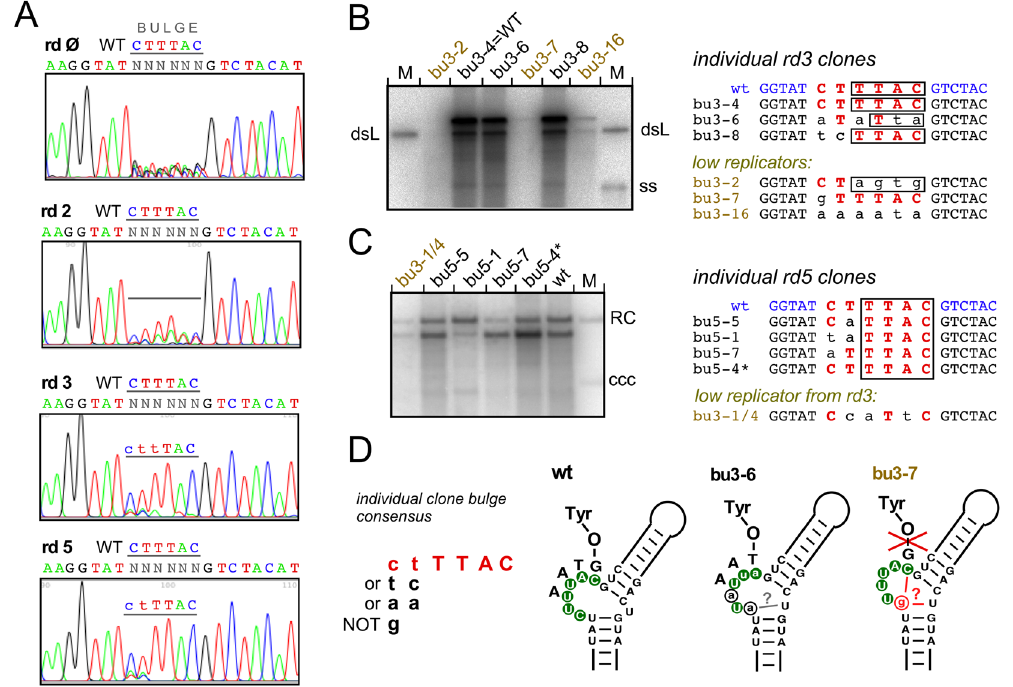
Figure 3. In-cell SELEX efficiently selects for wt-like D ε bulge template sequences. A pool of pCD16- Δ 3 ′ε vectors bearing random nt at the six bulge positions was subjected to sequential transfection/selection rounds as detailed in Supplementary Methods. ( A ) Pool sequencing. Sequencing chromatograms were obtained from the recombinant vector pool before transfection (round Ø) and the new vector pools generated after the indicated number of SELEX rounds. Note the increasing proportion of sequences conforming to the genuine template sequence TTAC, and the persistence of some heterogeneity at bulge positions 1 and 2. ( B ) Replication capacity of individual round 3 clones in transfected LMH cells. The round 3 pool comprised a mixture of high and low replicators; their sequences are shown on the right; the bulge sequence is in red, the template region is boxed. Lower case black letters indicate non-wt nt. ( C ) Replication capacity of individual round 5 clones. All sampled individual clones were replication-competent; round 3 clone bu3-1/4 served as low replicator control. ( D ) Functional bulge consensus sequences derived from individually characterized clones. Despite some heterogeneity at bulge positions 1 and 2, most high replicators contained the authentic template sequence TTAC, low replicators deviated from that sequence (e.g. bu3-2, bu3-16). The schemes show wt-D ε (SELEX- targeted nt in white letters with green background) vs. the exceptional clones bu3-6 and bu3-7. Clone bu3-6 replicated at near wt-level despite an altered template sequence; non-wt nt are given in lower case. However,